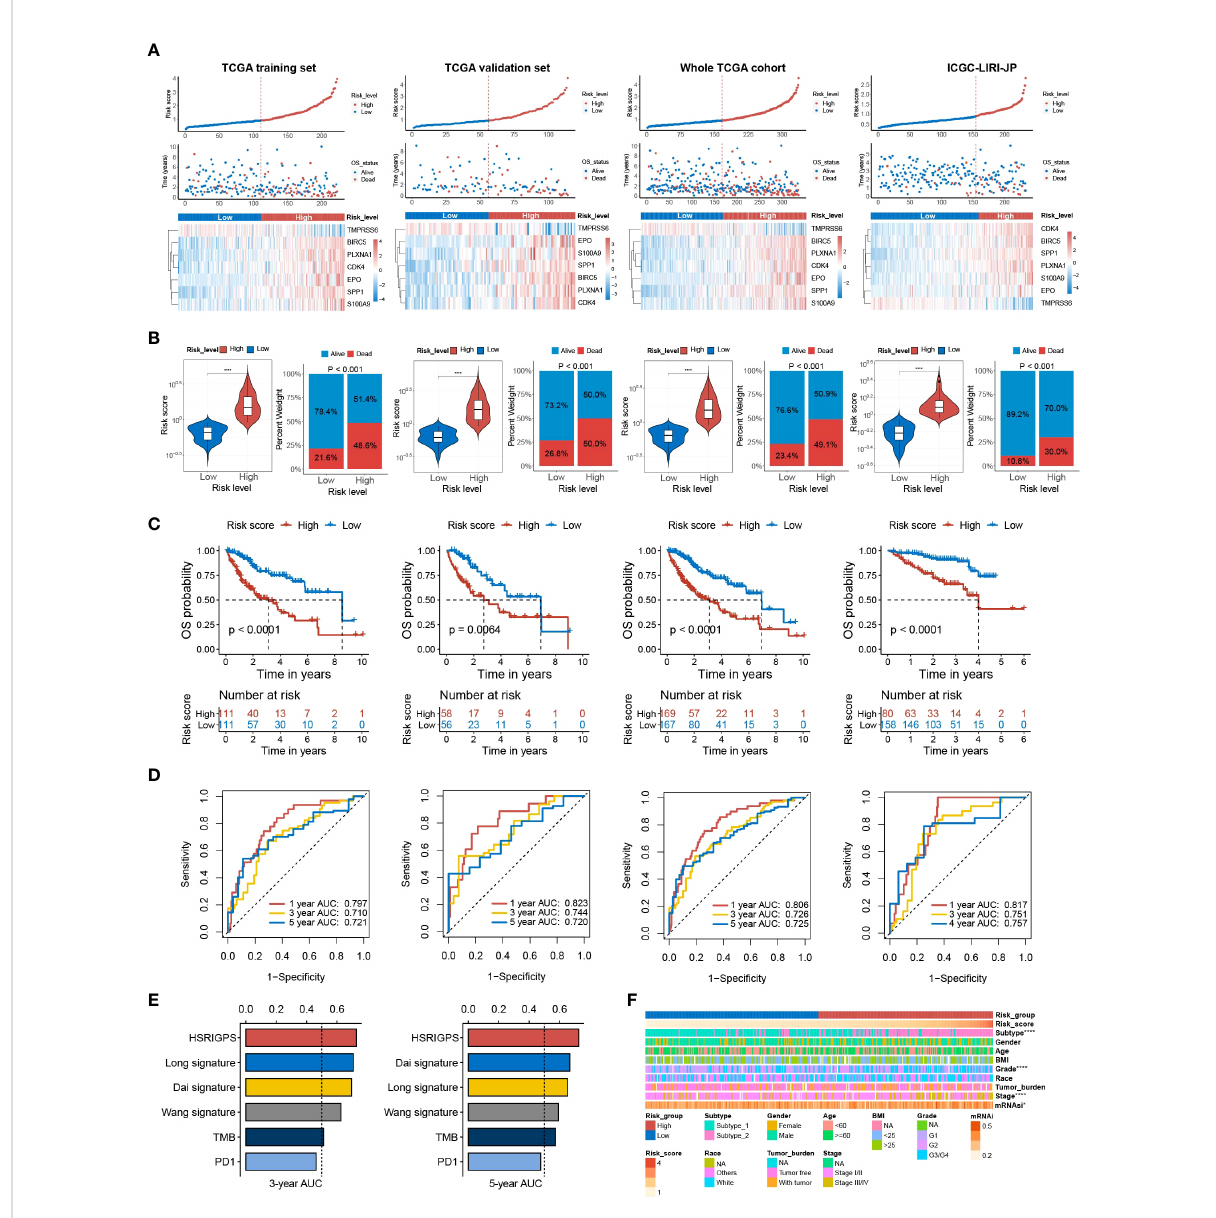
FIGURE 4 Prognostic value of HGSIS for OS in HCC patients. (A) Risk score distribution, survival status, and the expression of seven HGSIS signature genes for patients in the low- and high-risk groups from four datasets (TCGA training set, TCGA validation set, whole TCGA cohort, and ICGC-LIRI-JP cohort). (B) Risk score and mortality rates of patients in the low- and high-risk groups from four datasets. (C) Kaplan – Meier survival plots of the low- and high-risk groups from four datasets for OS. (D) tROC curves of HGSIS in the four datasets. (E) The comparison of AUC values for the 3-year and 5-year survival between HGSIS and other published signatures or common immunotherapeutic biomarkers. (F) Correlation analysis between HGSIS and multiple clinicopathological traits. **** means p <